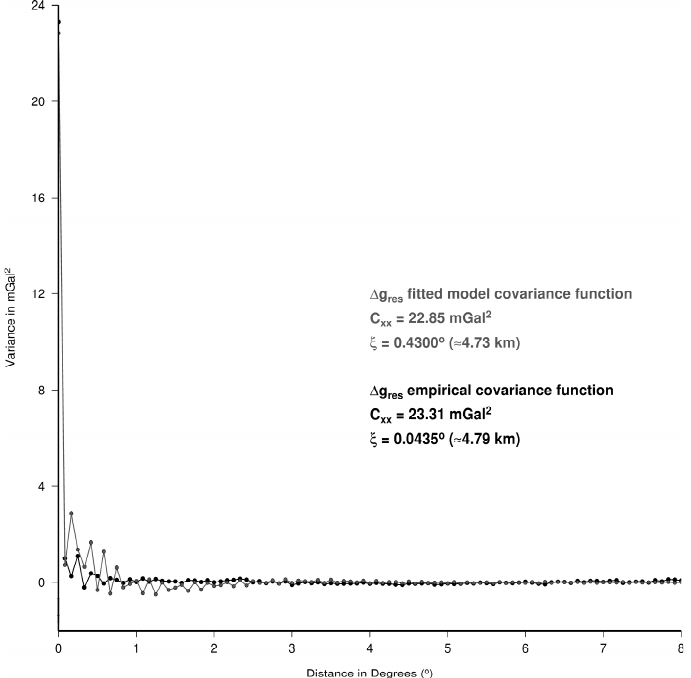
Figure 13. Empirical covariance function of the residual local gravity anomalies (black dashed line) and fitted model covariance function of the residual field (gray dashed line).